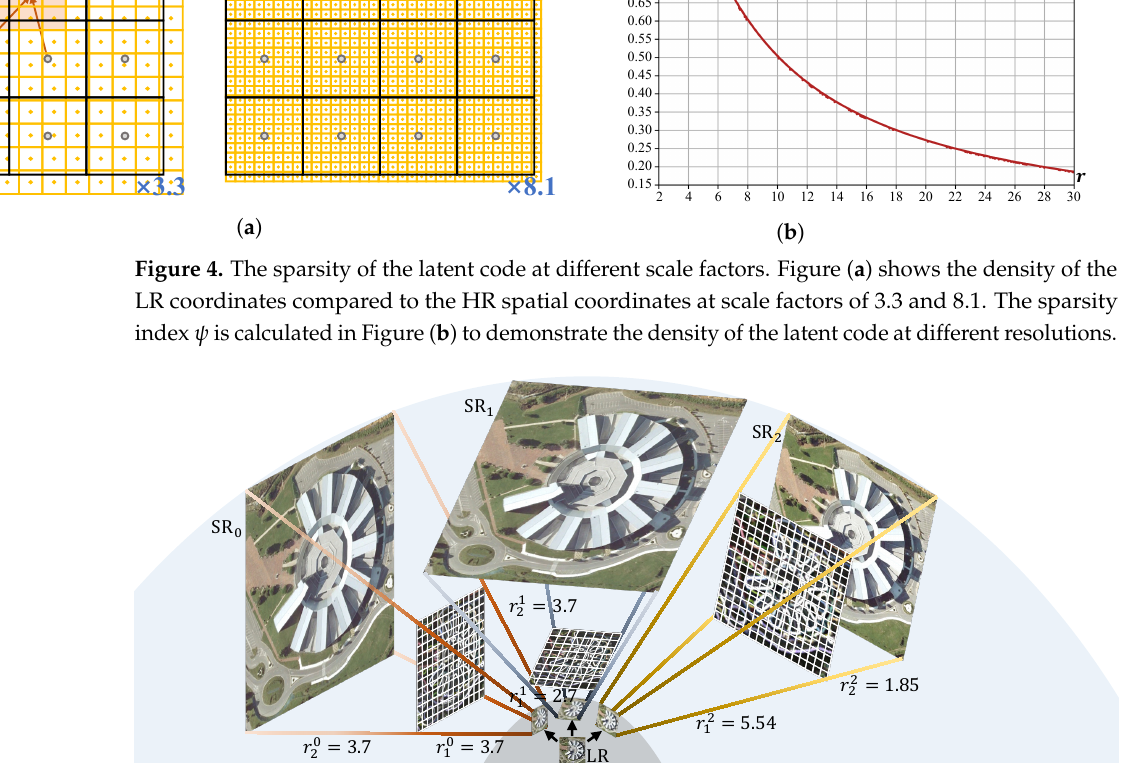
denotes the i -th scale i